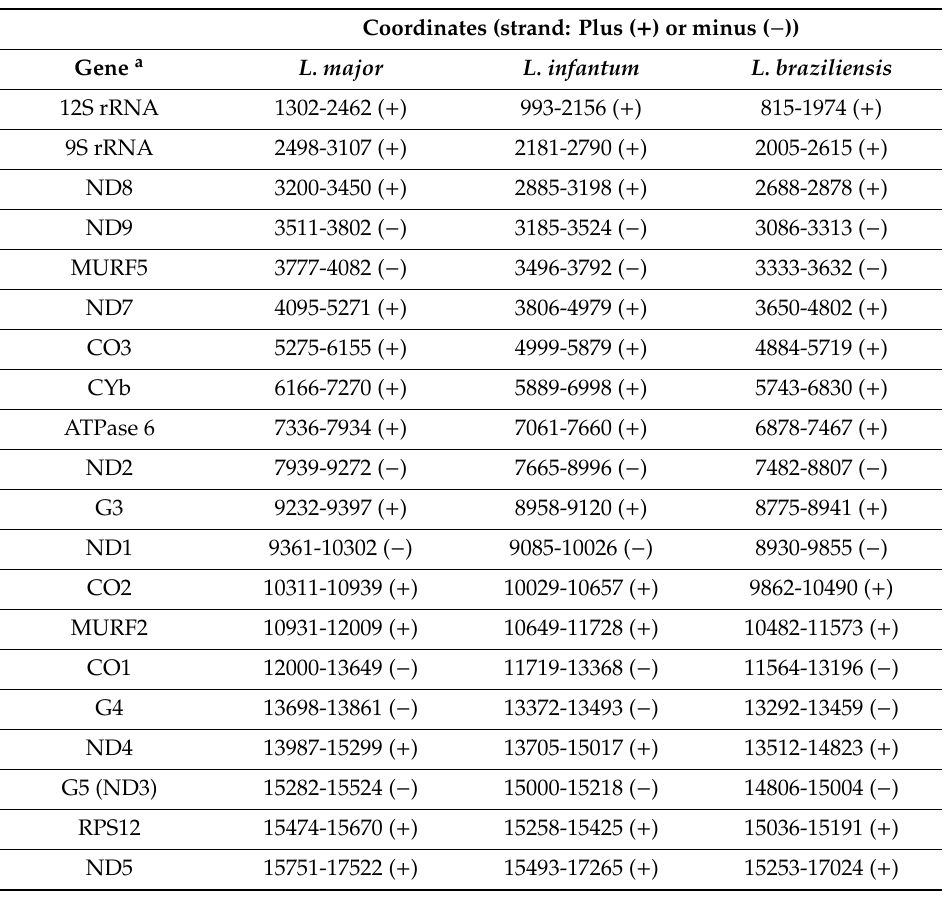
Table 1. Genes and their location in the Leishmania major , L. infantum and L. braziliensis